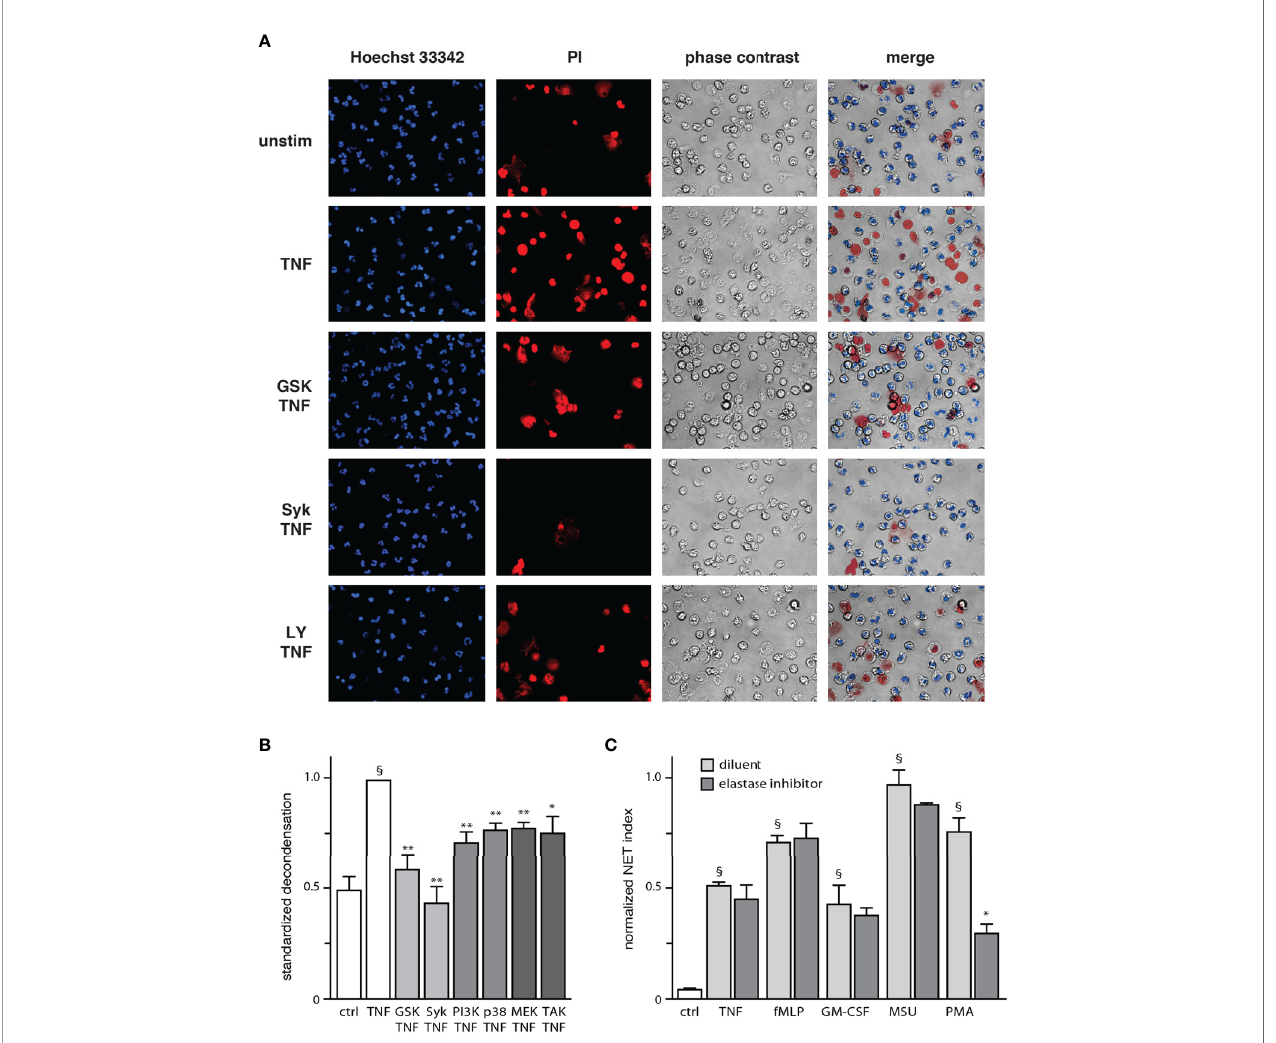
FIGURE 2 | Chromatin decondensation is a late event in NET generation. (A) Neutrophils cultured on poly-L-lysine-coated coverslips in a culture incubator were pre-treated (15 min) with the following inhibitors or their diluent (DMSO): 10 µM piceatannol (Syk inhibitor); 10 µM LY294002 (PI3K inhibitor); or 10 µM GSK484 (PAD4 inhibitor). The cells were then incubated at 37°C for 2.5 h in the absence or presence of 100 U/ml TNF a , at which point the following nuclear dyes were added: Hoechst 33342 (cell-permeable, to stain all nuclei) and propidium iodide (cell-impermeable, to stain cells whose membrane had ruptured). The cells were then further incubated at 37°C for another 30 min (3.5 h total stimulation time) before confocal microscope analysis. A representative experiment is shown. (B) Quantitative compilation of these experiments, for which the % cells with nuclei showing decondensed chromatin was standardized to the value of stimulated cells. Mean ± s.e.m. from at least 3 independent experiments; *p < 0.04 vs stimulus alone; **p < 0.01 vs stimulus alone; §p < 0.001 vs unstimulated cells). (C) Neutrophils cultured on poly-L-lysine-coated coverslips were treated 15 min before stimulation with 10 µM GW311616A (an elastase inhibitor) or its